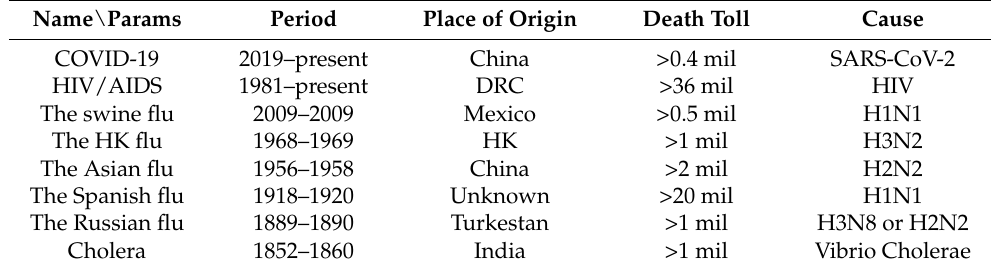
Table 1. Recent pandemics and their characteristics. Source: Centres for Disease Control and Preven- tion (2020). Name \ Params Period Place of